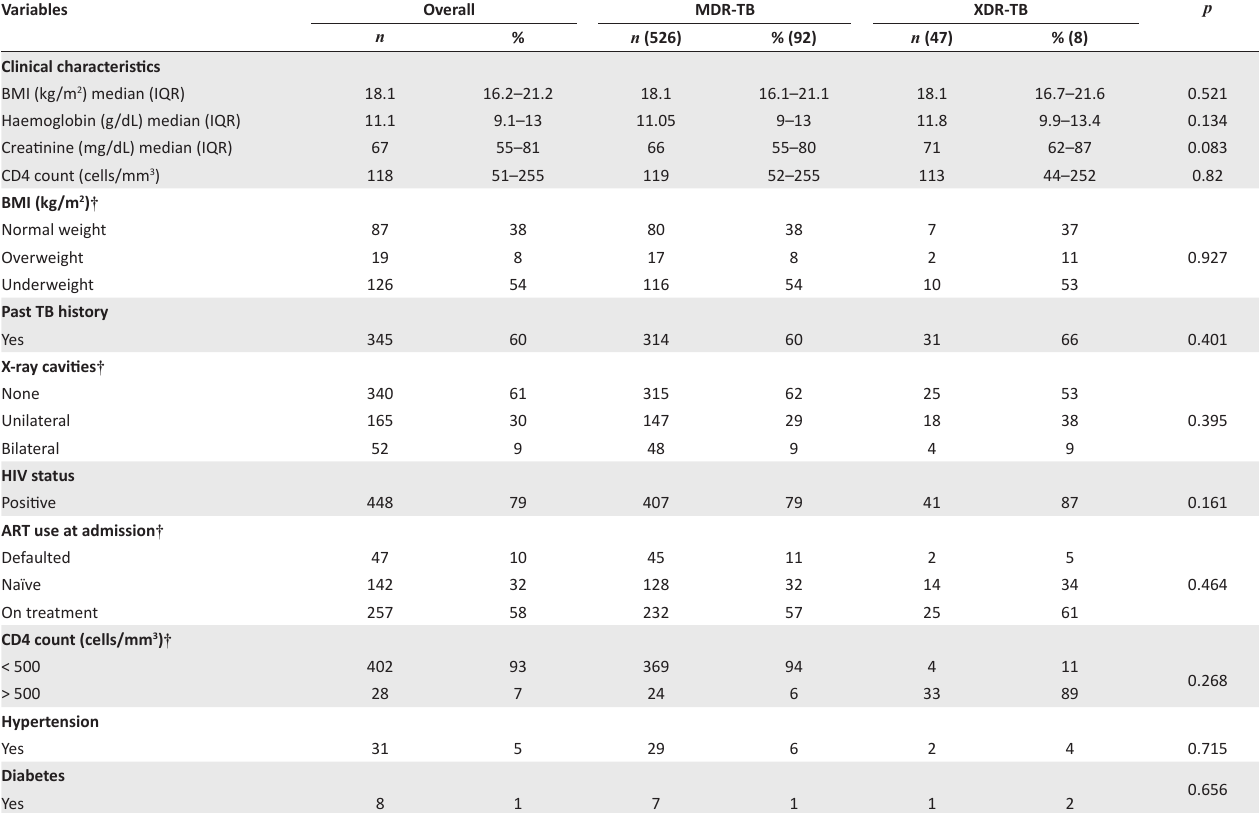
TABLE 2: Clinical characteristics of the participants.